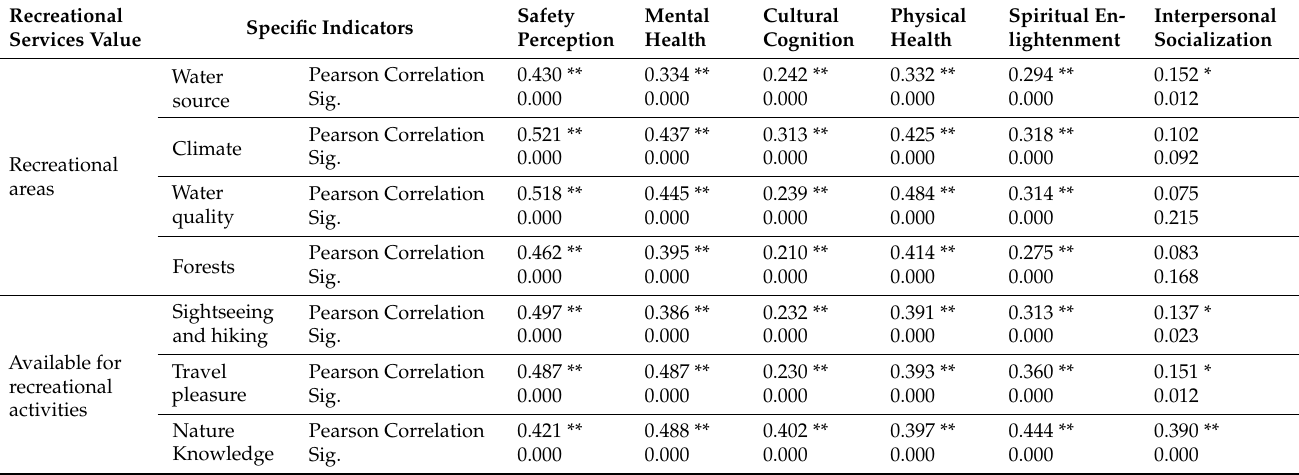
Table 2. Correlation analysis of tourist’s well-being, reflecting the value of recreational